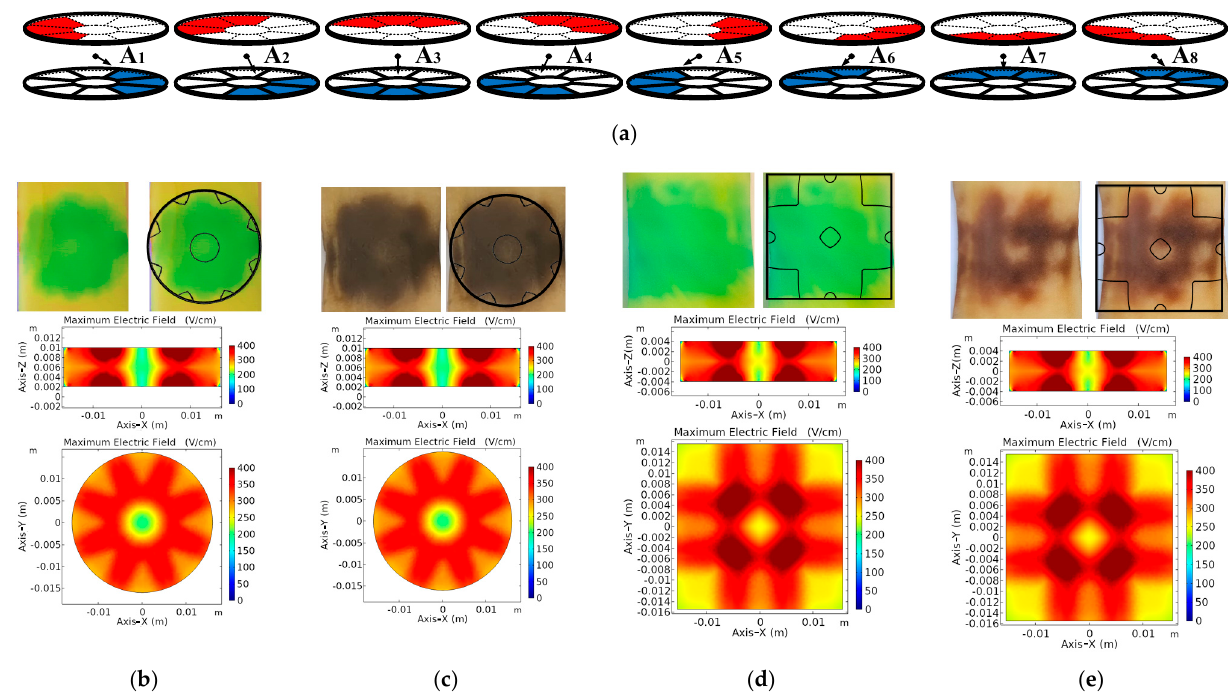
Figure 10. Result of the application in plant tissue of 8 CSs: ( a ) applied CSs, ( b ) photo of the dyed potato and simulated maximum electric field at each point, using circular electrode, ( c ) photo of the degraded potato and simulated maximum electric field at each point, using circular electrode, ( d ) photo of the dyed potato and simulated electric field, using square electrode, and ( e ) photo of the degraded potato and simulated electric field, using square electrode.